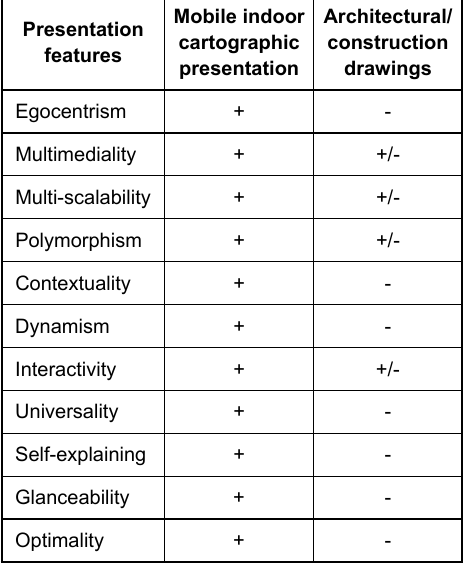
Table 1. The comparison of the significance of selected presentation features for cartographic presentation in a mobile indoor application and architectural/con- struction drawings in CAD